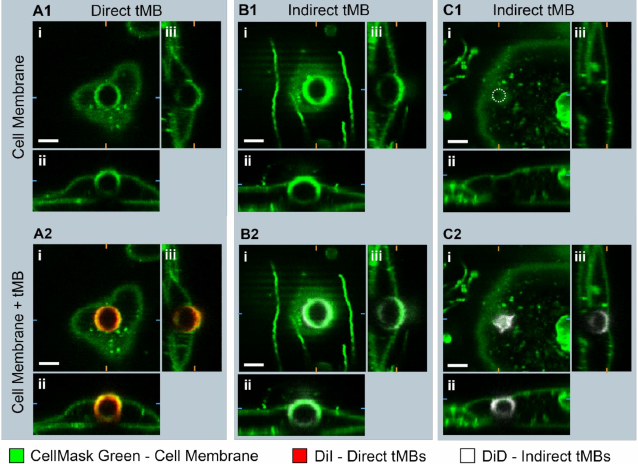
Figure 6. Orthogonal views of confocal microscopy z -stack of ( A1 , A2 ) bound direct microbubble (diameter 6.0 µ m, internalized depth 5.5 µ m), ( B1 , B2 ) bound indirect microbubble (diameter 5.8 µ m, internalized depth 4.7 µ m), and ( C1 , C2 ) bound indirect microbubble (diameter 3.7 µ m, internalized depth 4.4 µ m) with microbubble location marked with white dotted circle in C1. Side views were imaged with the objective from ( ii ) above or ( iii ) the right. Scale bar represents 5 µ m, orange and blue markings indicate the cross-section of the orthogonal planes of the side